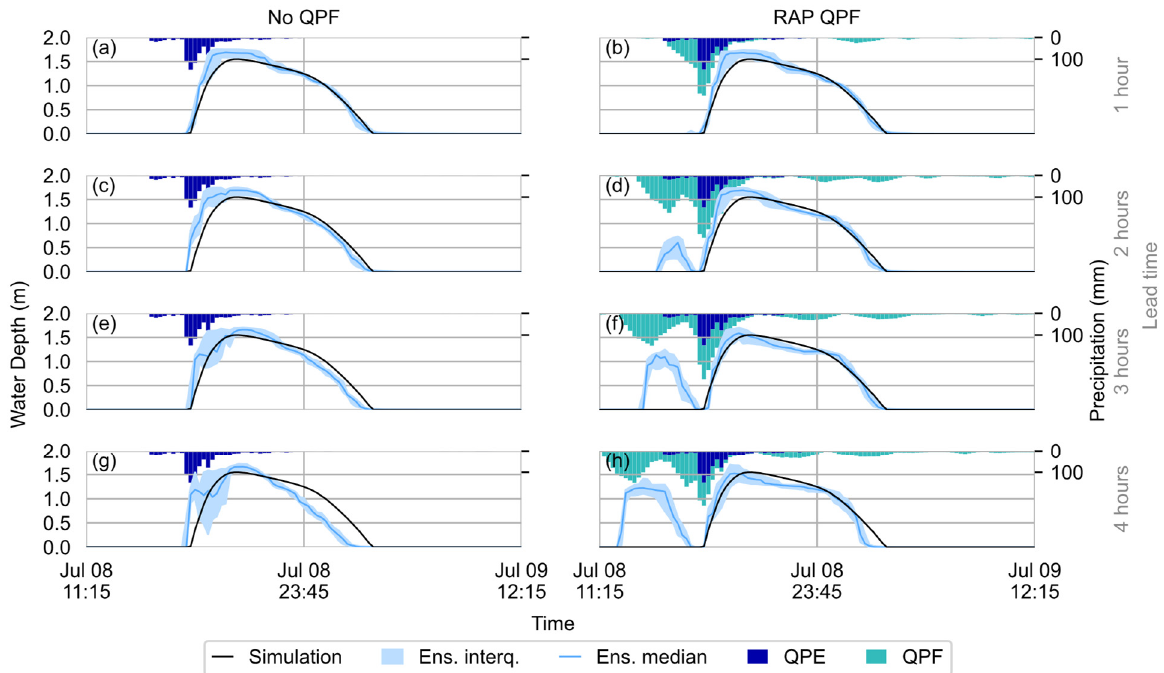
Figure 10. Water depth simulated and ensemble forecasts for POI 1 at lead times of ( a , b ) 1 h, ( c , d ) 2 h, ( e , f ) 3 h and ( g , h ) 4 h for the event of 8 July 2013.